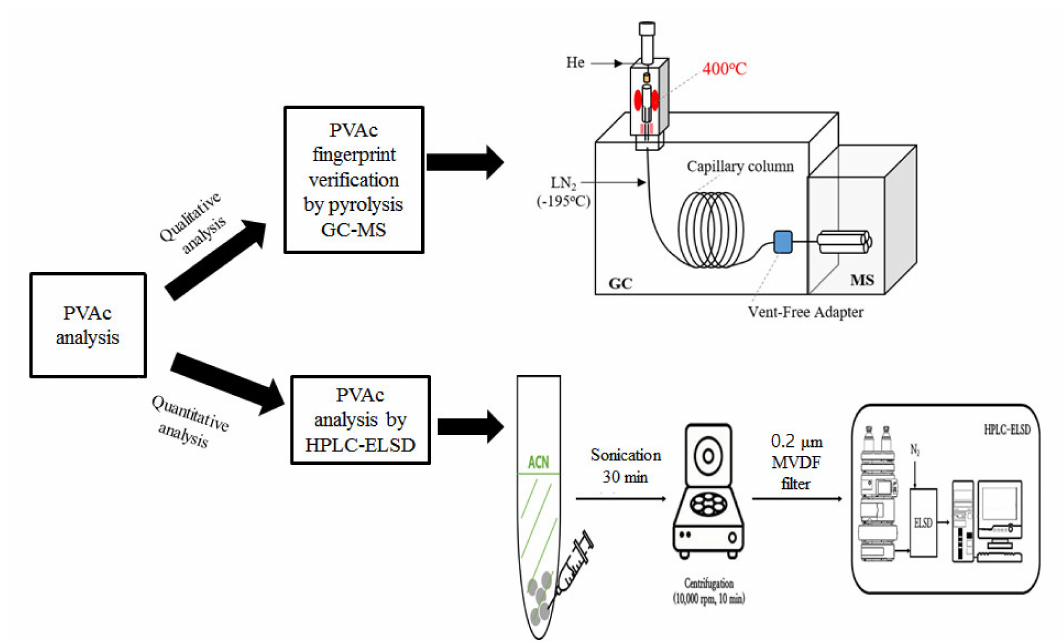
Figure 2. Strategy of polyvinyl acetate (PVAc) analysis and its analytical conditions. GC-MS, gas chromatography–mass spectrometry; HPLC–ELSD, high-performance liquid chromatography with an evaporative light scattering detector; LN 2 , liquid nitrogen gas; ACN, acetonitrile;